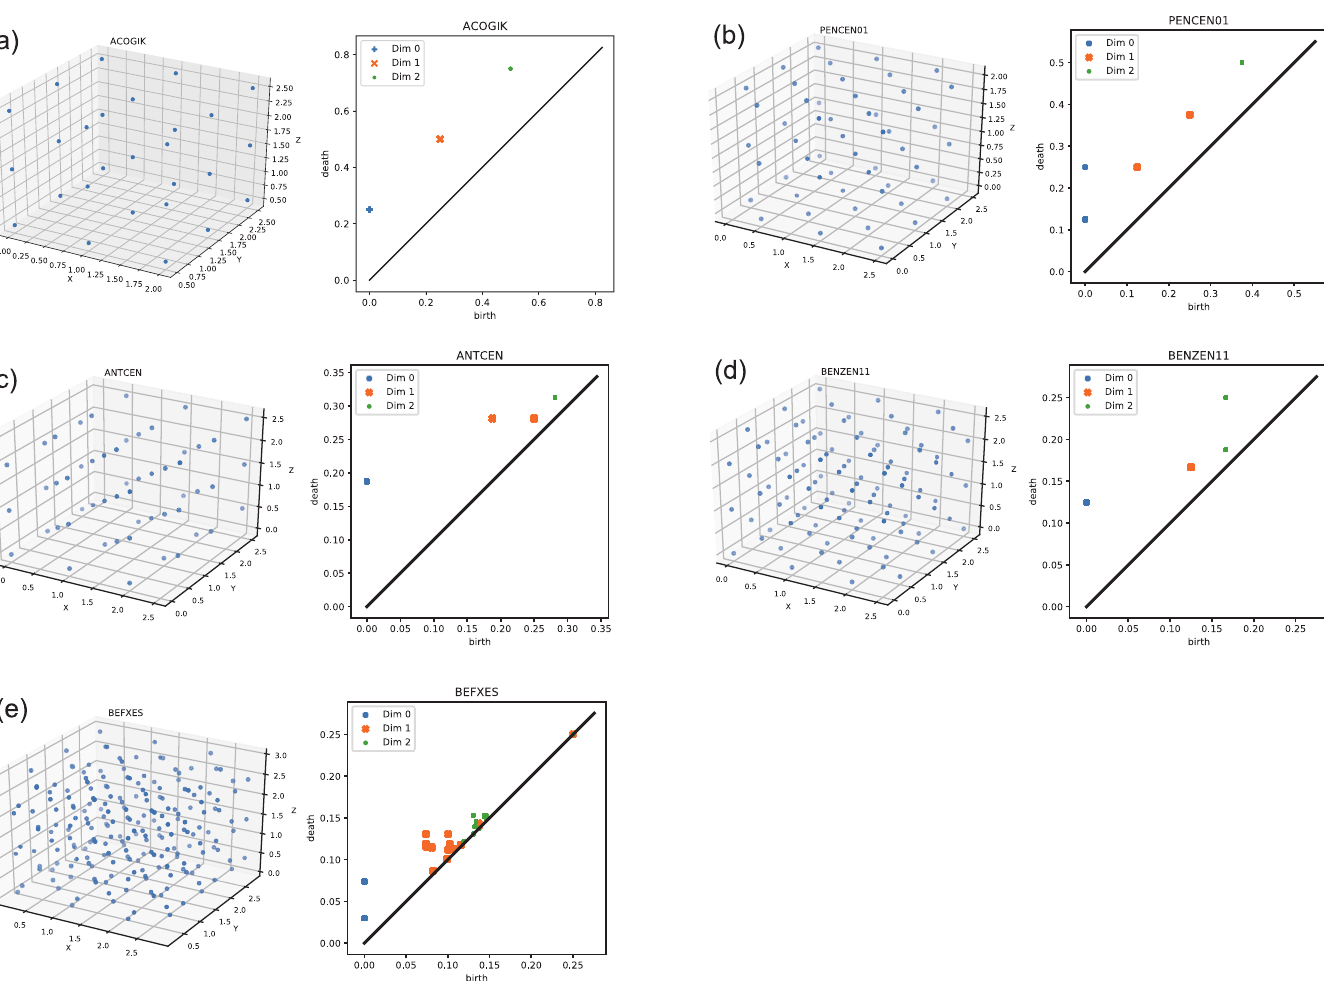
Fig 6. Examples of persistence diagrams for organic crystals. Molecular centroids (left) and corresponding persistence diagrams (right). In each persistence diagram, the blue pluses, orange crosses, and green circles indicate the plots of D q with q = 0, q = 1, and q = 2, respectively. (a) 9,10-bis(2-(4-(n-Decyloxy)phenyl)vinyl)anthracene (PAs) with type-P structure. (b) Pentacene (PAHs) with type-C structure. (c) Anthracene (PAHs) with type-I structure. (d) Benzene (PAHs) with type-F structure. (e) Acenaphthobenzopicene (PAHs) which is categorized into